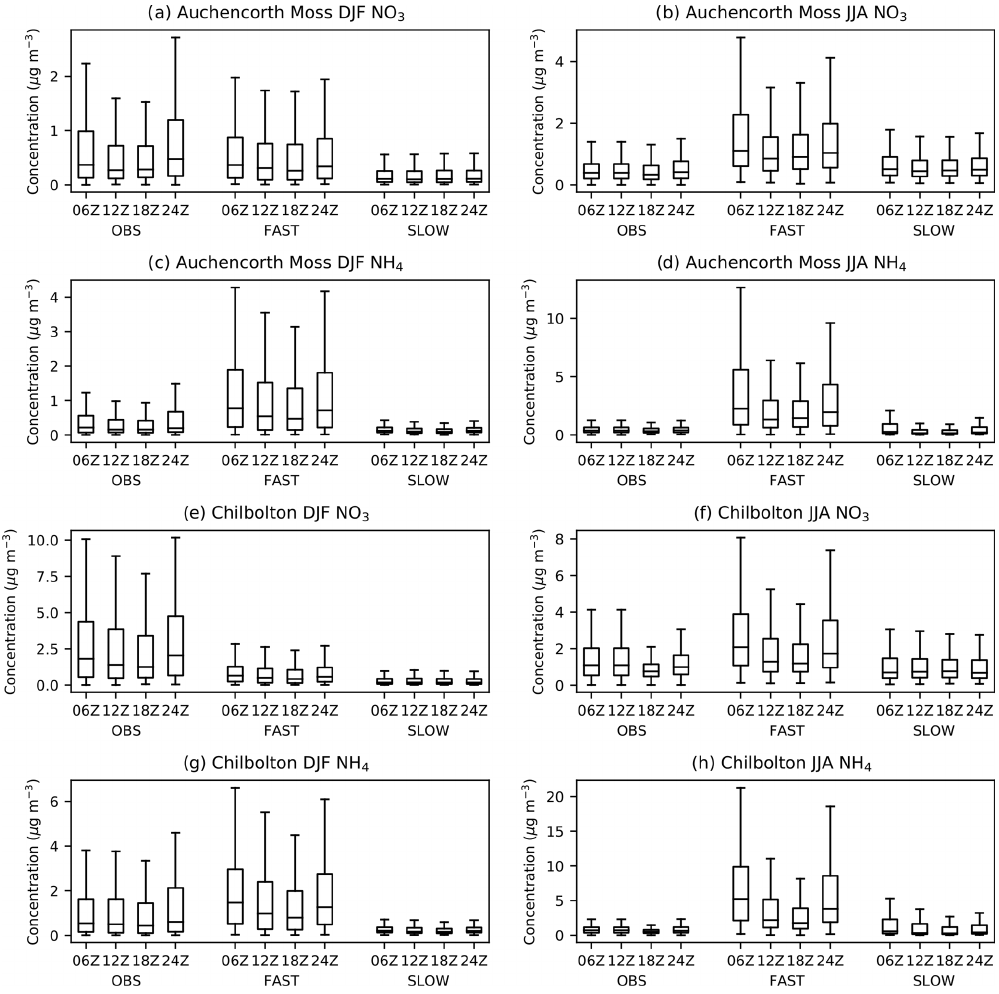
Figure 7. December–February (DJF) and June–August (JJA) diurnal cycles of near-surface total-NO 3 and NH 4 aerosol concentrations in the FAST and SLOW simulations interpolated to two European Monitoring and Evaluation Programme (EMEP) supersites in the UK – Auchencorth Moss (55.79216 ◦ N, − 3 . 2429 ◦ E) and Chilbolton (51.149617 ◦ N, − 1 . 438228 ◦ E), alongside six hourly observations from 2014–2018 for Auchencorth Moss and 2016–2020 for